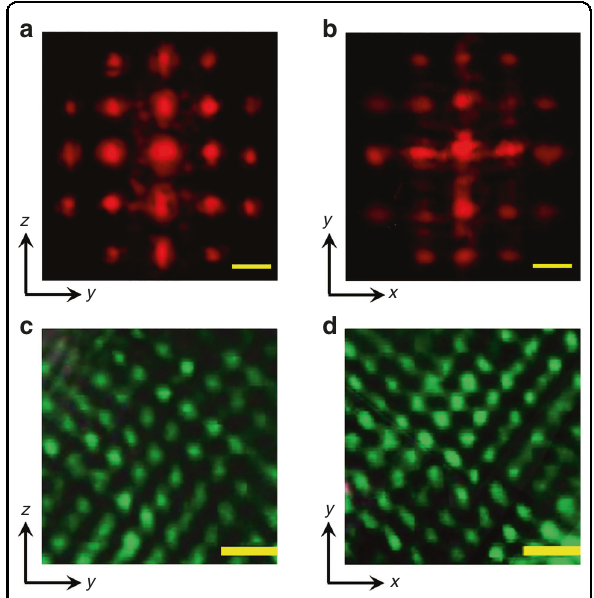
Fig. 2 Linear and nonlinear optical response of the KTN crystal. a , b The Bragg diffraction spots from the x-cut and z-cut KTN samples (the scale bar is 2cm). c , d The second harmonic (SH) microscopic pattern of the x-cut KTN sample and z-cut KTN sample (the scale bar is 25 μ